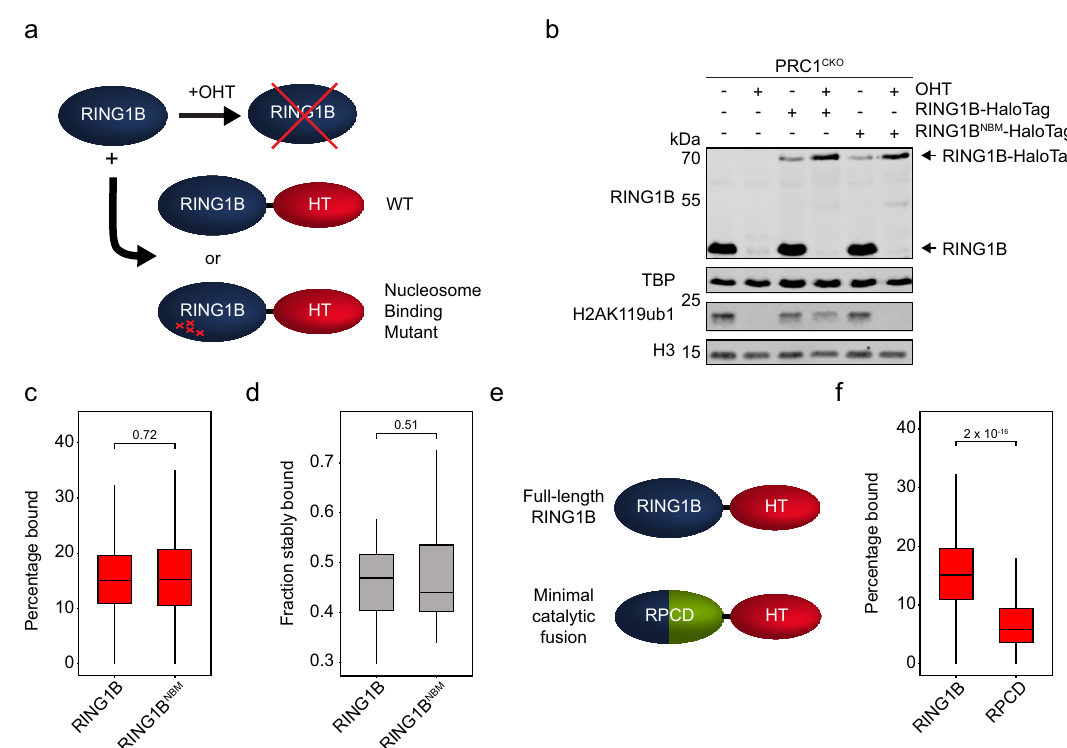
Fig. 4 Interaction between the PRC1 catalytic core and the nucleosome is not a central determinant of chromatin binding. a A schematic illustrating the cell line used for exogenous expression of RING1B-HaloTag fusions. Either wild type (WT) RING1B or a nucleosome binding mutant (NBM) fused to the HaloTag was stably expressed in Ring1a -/- ; Ring1b fl / fl (PRC1 CKO ) cells. Addition of OHT causes removal of endogenous RING1B. b Western blots showing loss of endogenous RING1B and H2AK119ub1 following addition of OHT in PRC1 CKO cells and rescue of H2AK119ub1 by RING1B-HaloTag but not RING1B NBM -HaloTag. TBP and H3 are included as loading controls. n = 1 biological replicate. Source data are provided as a Source Data fi le. c A box plot indicating the percentage of RING1B and RING1B NBM molecules in the bound state as determined by SPT. Box plots represent measurements from n > 90 movies of different cells from 3 experiments. The indicated p -value was calculated using a two-tailed Student ’ s t test. Source data are provided as a Source Data fi le. d A box plot showing the fraction of RING1B and RING1B NBM molecules that exhibit stable binding. Box plots represent measurements from n = 16 movies from 2 experiments. The indicated p -value was calculated using a two-tailed Student ’ s t test. e . Schematic showing the minimal RING1B PCGF4 catalytic domain (RPCD) formed by fusion of the RING domains of RING1B and PCGF4. Source data are provided as a Source Data fi le. f A box plot of percentages of RING1B and RPCD molecules in the bound state. Box plots represent measurements from n > 90 movies from 3 experiments. The indicated p value was calculated using a two-tailed Student ’ s t test. Source data are provided as a Source Data fi le. In c , d , f boxes represent the interquartile range (IQR), the middle line corresponds to the median, and whiskers extend to the largest and smallest values no more than 1.5 x IQR from the box. Values outside of this range are not plotted, but are included in all